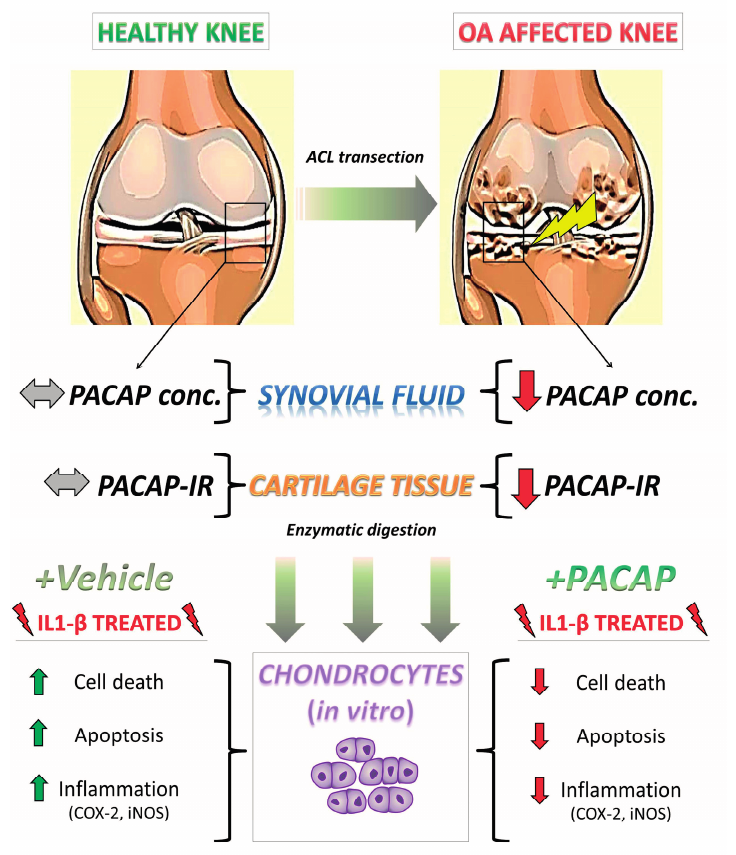
Figure 7. Schematic illustration depicting PACAP regulation in the proposed model of OA and its beneficial effects in isolated chondrocytes after IL-1 β insult. Upon anterior cruciate ligament transection (ACLT), rats progressively develop clinical signs of OA, including cartilage deterioration and local inflammatory response [55,56]. In this scenario, PACAP immunoreactivity, which was detectable at high intensities in chondrocytes localized in the outer regions of the healthy cartilage is significantly reduced by experimental induction of OA. Such an event is accompanied by the reduction of PACAP concentration in the synovial fluid and a remarkable increase in intra-articular presence of the pro-inflammatory cytokine IL-1 β , suggestive of an active inflammatory process. To assess whether PACAP contributed to prevent chondrocyte death, these cells were isolated through enzymatic digestion and challenged with IL-1 β , to partly mimic the inflammatory milieu observed in vivo . Results show that PACAP treatment ameliorated most of the detrimental effects of the cytokine, acting both as a chondroprotective and anti-inflammatory molecule. PACAP conc. = PACAP concentration; PACAP-IR = PACAP